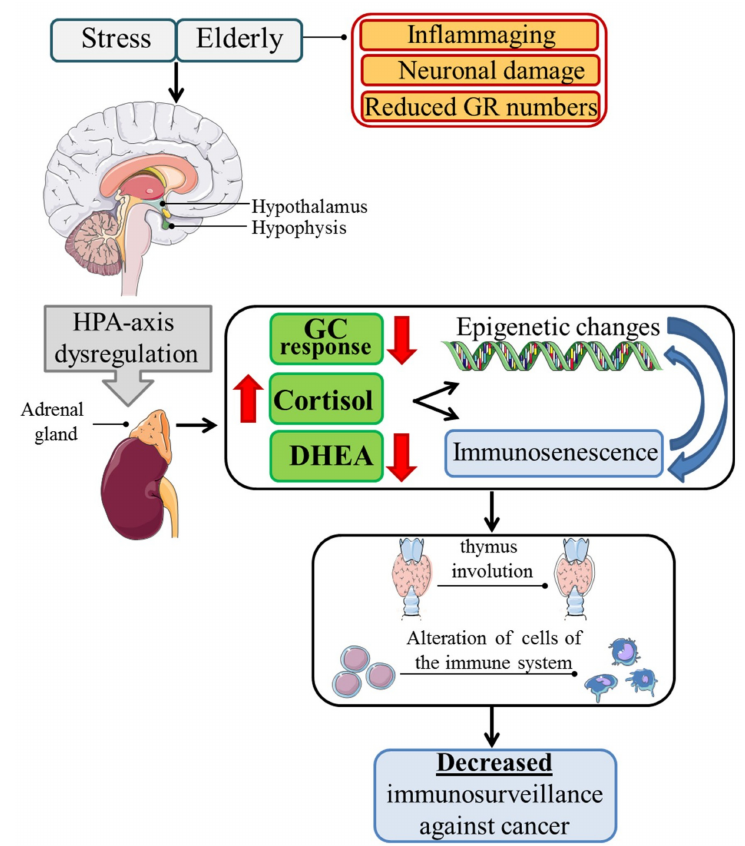
Figure 1. Aging and chronic stress share common mechanisms. Aging, characterized by hippocampal neuronal loss, glucocorticoid receptor (GR) reduction in the hippocampus and hypothalamic paraventricular nucleus, and inflammaging, together with chronic stress, induces hypothalamic–pituitary–adrenal (HPA) axis imbalance, with increased cortisol (red arrow, head up) and decreased dehydroepiandrosterone (DHEA) production and decreased response of target tissues to glucocorticoids (GCs). HPA-axis dysregulation contributes to both immunosenescence and epigenetic changes; the latter in turn aggravate immunosenescence (red arrows, head down), with the final result of thymic involution, immune cell alterations, and decreased immunosurveillance against